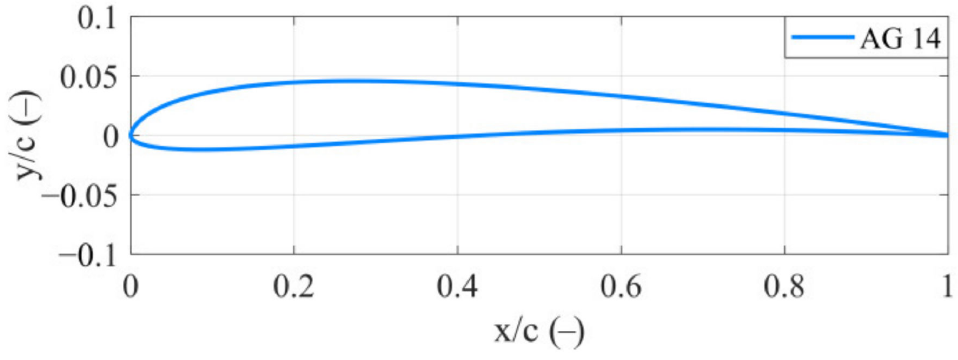
Figure 3. The geometry of AG 14